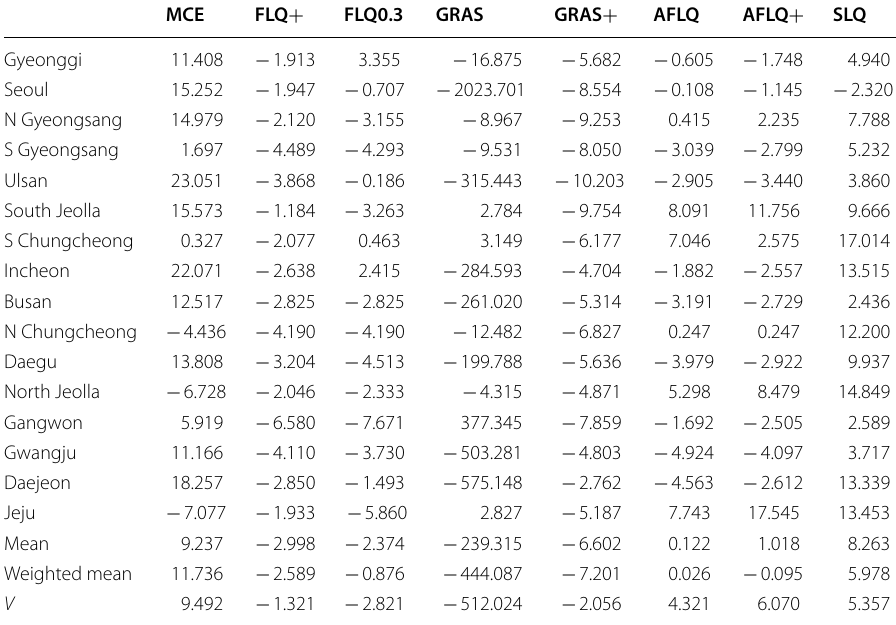
Table 11 Statistics of the mean percentage differences (MPEs) between the estimated and observed type I output multipliers from alternative